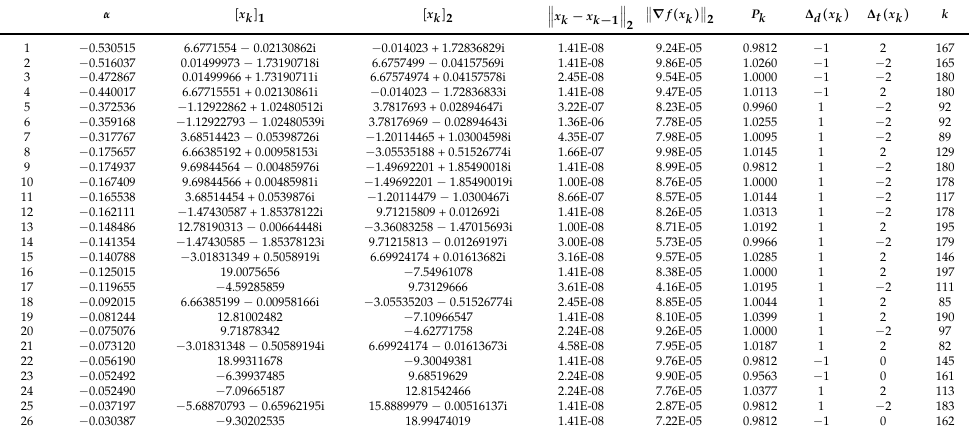
Table 1. Results obtained using the fractional quasi-Newton method